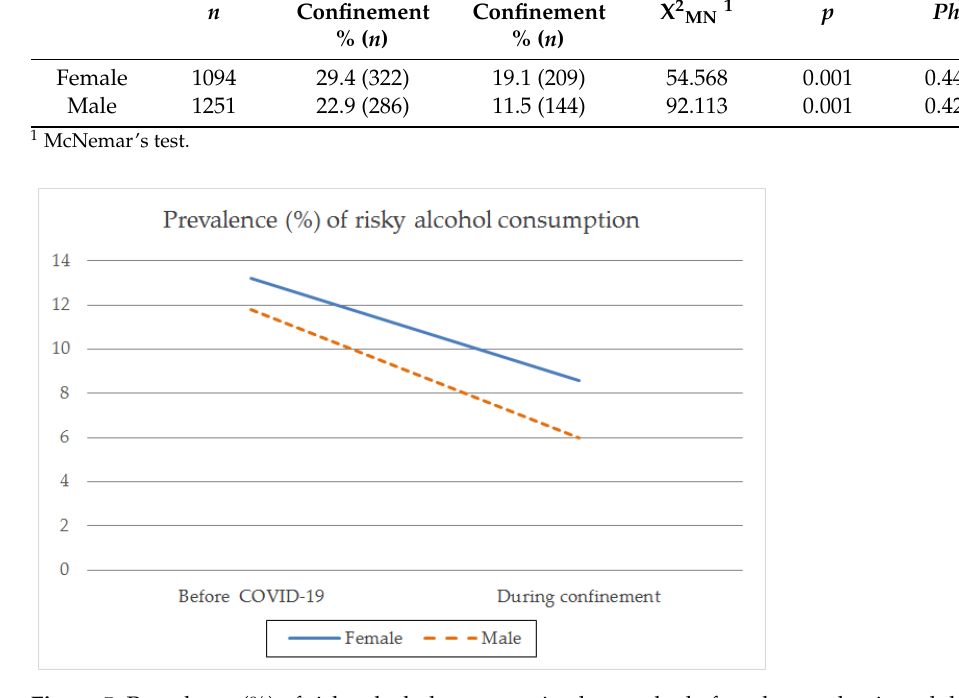
Figure 5. Prevalence (%) of risky alcohol consumption by gender before the pandemic and during COVID-19 confinement.